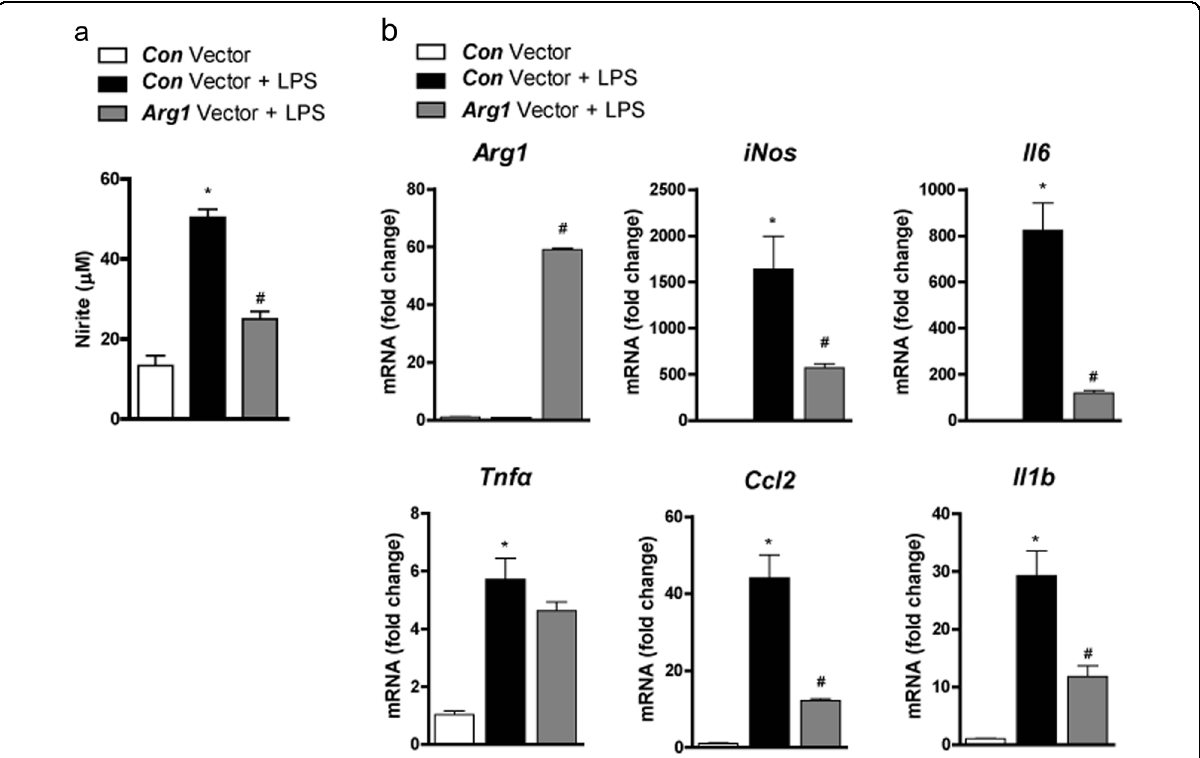
Fig. 4 Overexpression of Arg1 suppressed M1 polarization of macrophages. RAW264.7 cells were transfected with control vector ( Con vector) or arginase-1 vector ( Arg1 vector) and treated with or without lipopolysaccharides (LPSs). a Nitrite concentration in the culture supernatant of RAW264.7 cells after treatment with LPSs for 24 h. b Expression of Arg1 and M1 markers determined using real-time PCR. Data represent means ± SEMs ( n = 5). * P < 0.05 versus Con vector-treated RAW264.7 cells without LPS treatment; # P < 0.05 versus Con vector-treated RAW264.7 cells with LPS